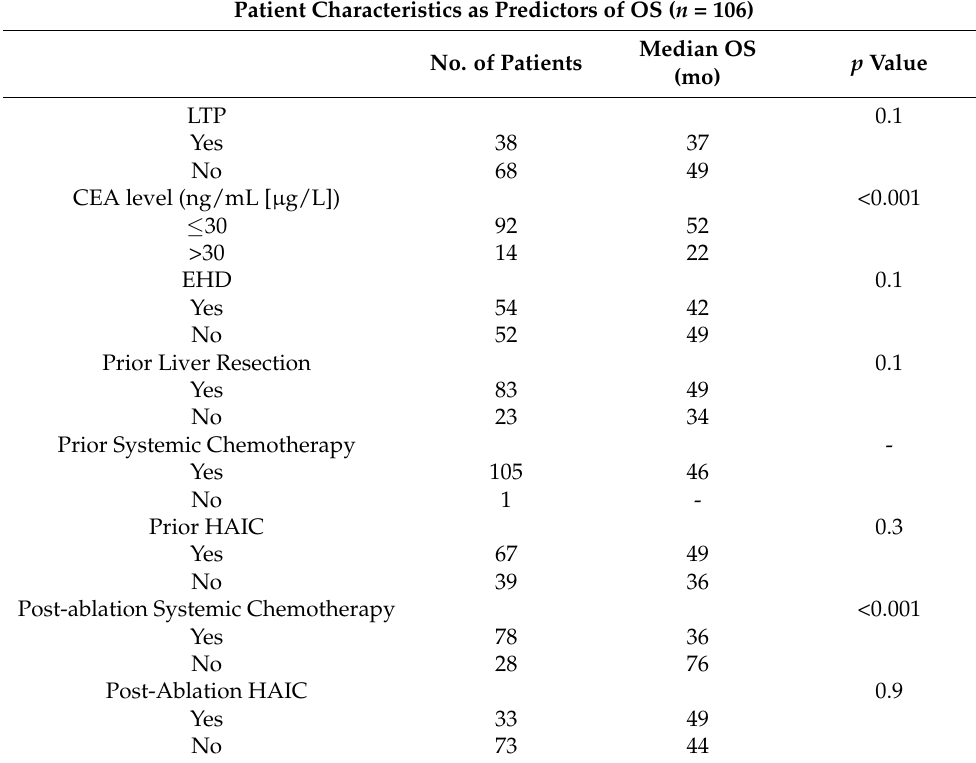
Table 4. Patient characteristics as predictors of overall survival. Patient Characteristics as Predictors of OS ( n =